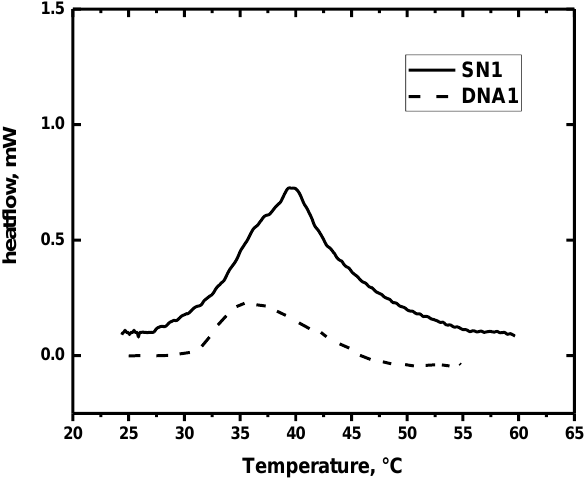
Figure 5. Differential scanning calorimetry (DSC) curves for SN1 and DNA1 hydrogels obtained during heating.